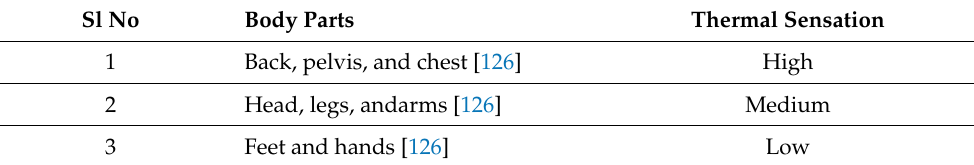
Table 9. The thermal sensation of body